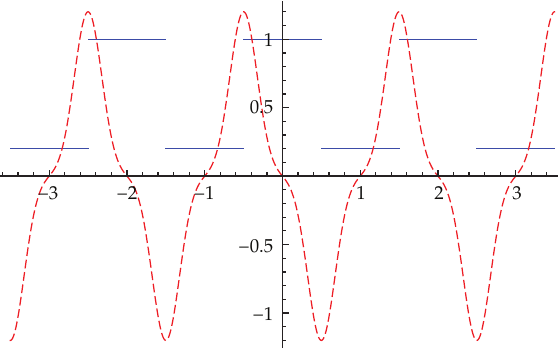
Figure 7: Derivative of a photodetector signal (cid:3) –– (cid:4) generated by a Gaussian beam scanning an infinite sequence of